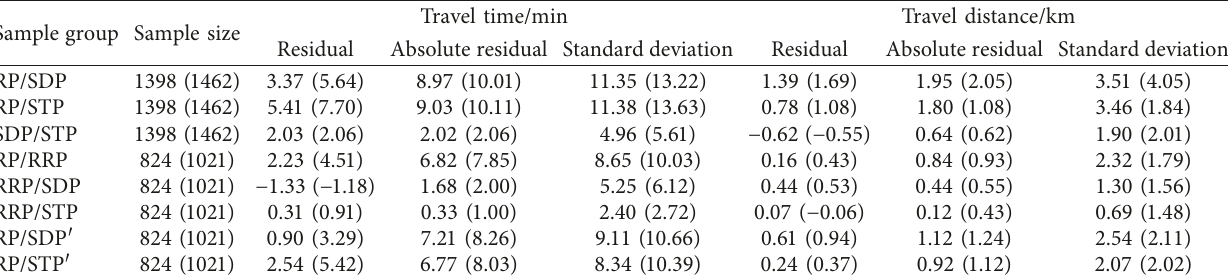
Table 5: The statistical description of the deviation between the actual and shortest paths.